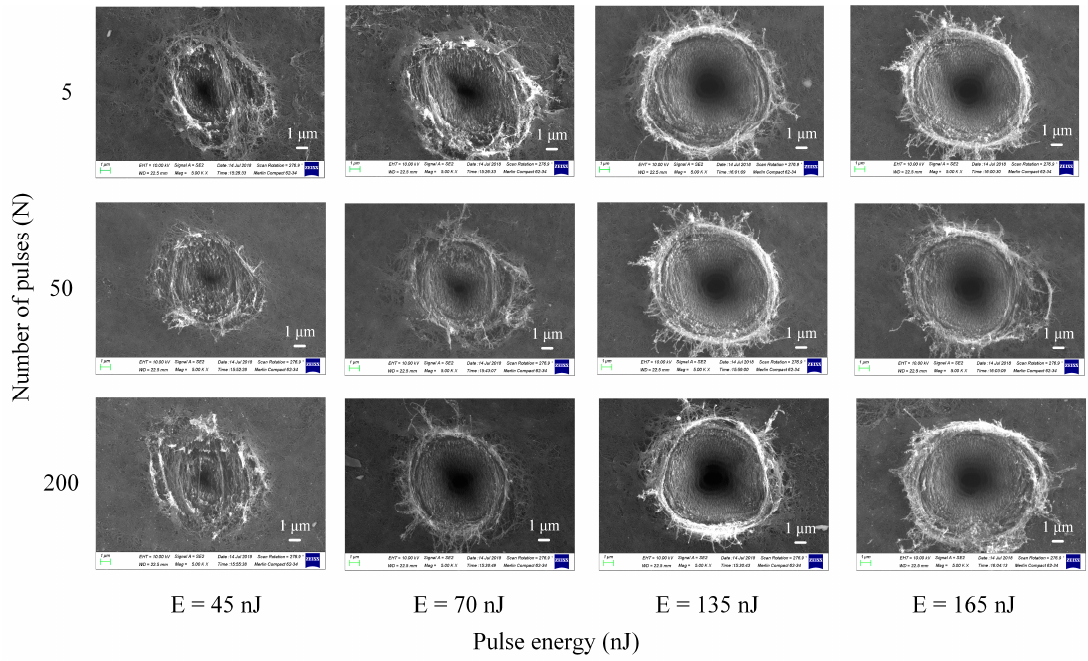
Figure 3. Ablation morphology at different pulse energies with the number of pulses N = 5, 50,